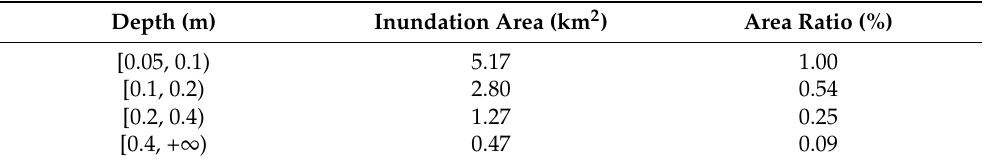
Figure 10. Maps of the maximum water depth. Table 6. Flood inundation in different grades.